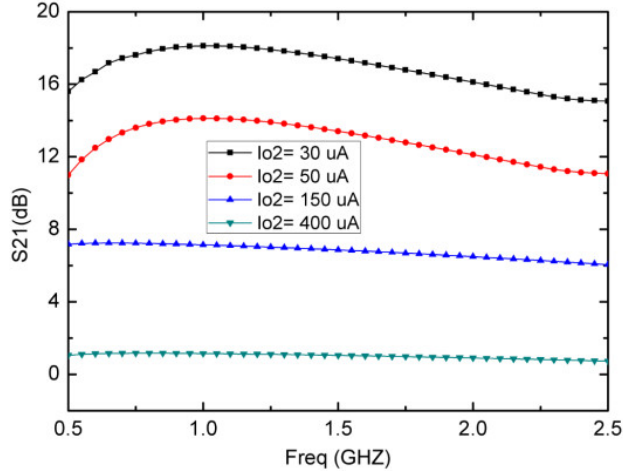
Figure 6. Simulated gain controllable range for various I o2 with I o1 = 1.25 mA and V DC = ±1.5 V.